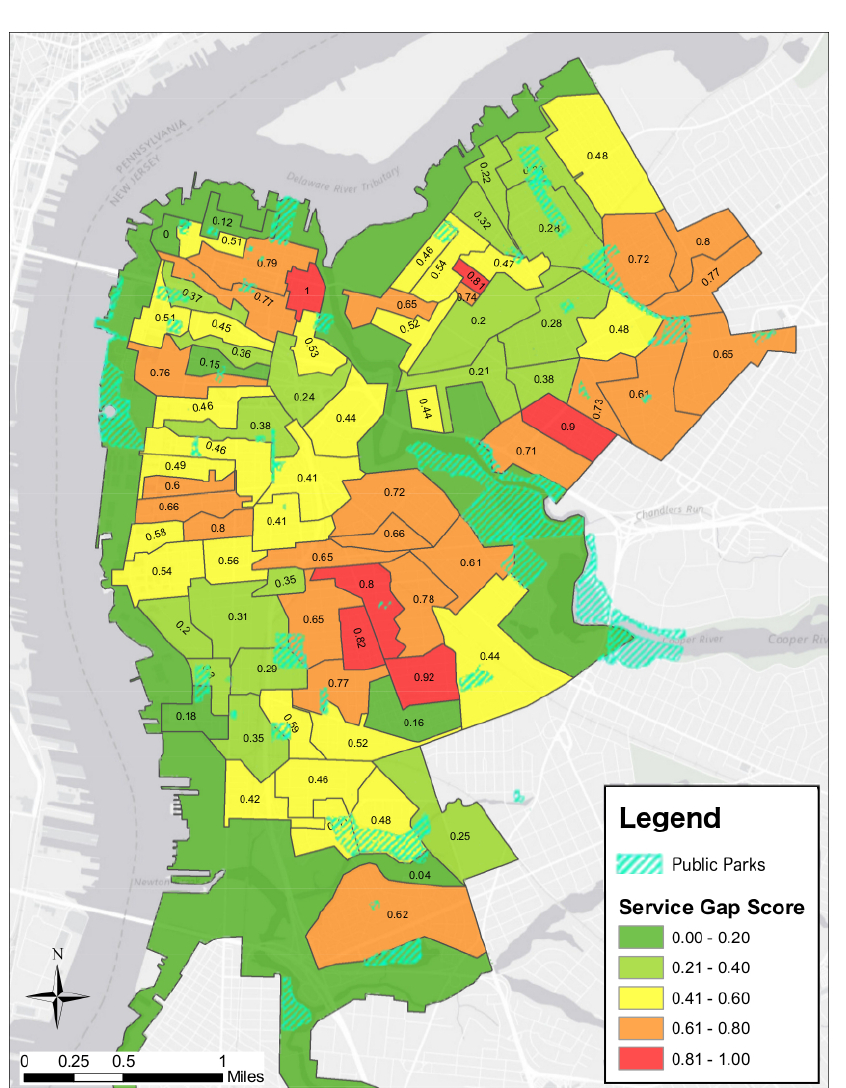
Figure 1. Combined ecosystem service gap score map for the city of Camden,